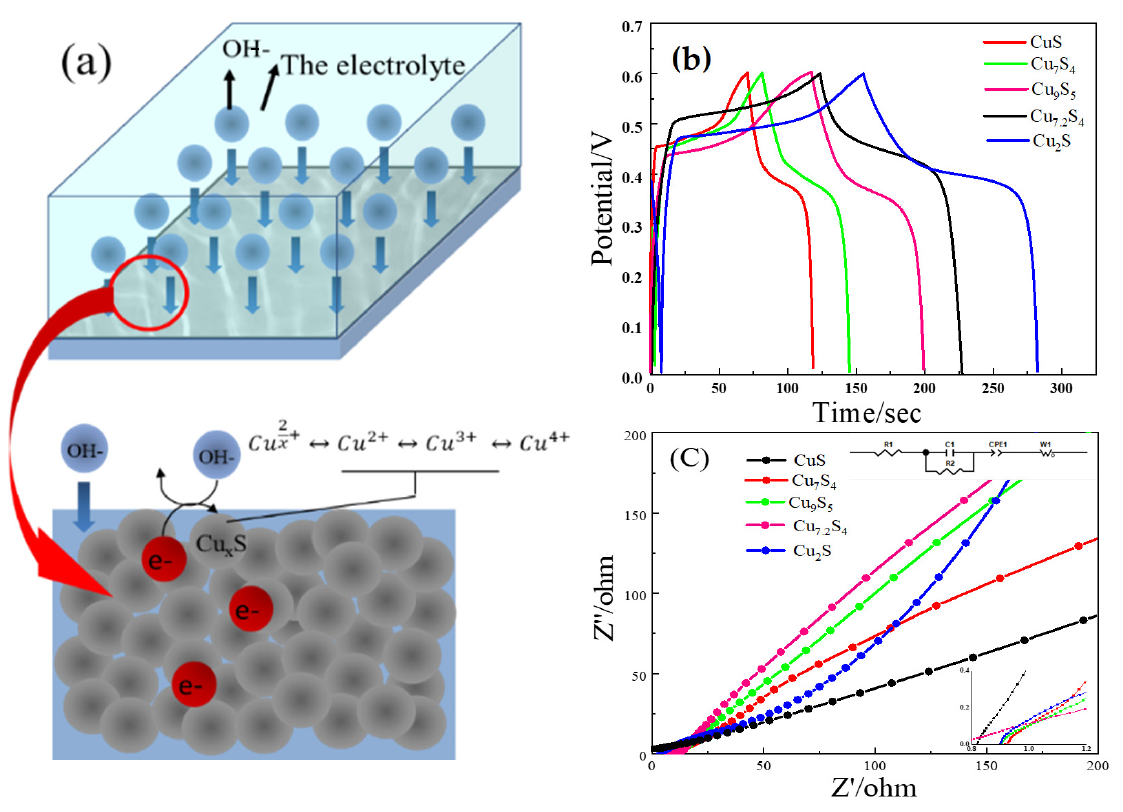
Figure 4. The schematic diagram of ( a ) energy storage of copper sulfide; the GCD diagrams of ( b ) different copper sulfides (CuS, Cu 9 S 5 , Cu 7 S 4 , Cu 7.2 S 4, and Cu 2 S) at 1 A/g current density; the electrochemical impedance spectroscopy (EIS) diagrams and equivalent circuit of ( c ) different copper sulfides.